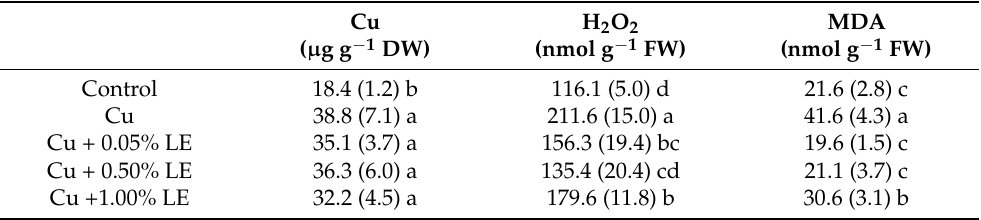
Table 2. Copper (Cu), hydrogen peroxide (H 2 O 2 ), and malondialdehyde (MDA) found in control maize, samples treated with Cu alone and in combination with 0.05%, 0.50% and 1.00%